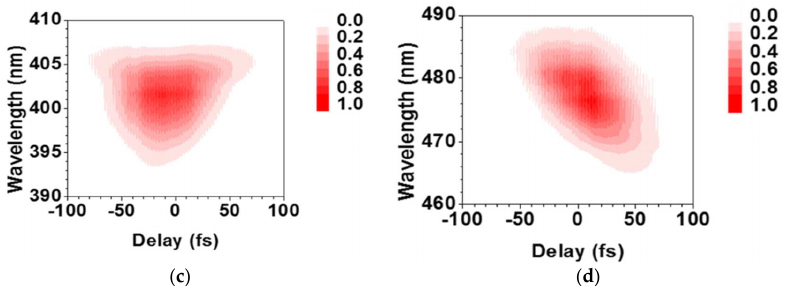
Figure 6. ( a ) Measured XFROG trace; ( b ) Retrieved XFROG trace from ( a ); ( c , d ) The expanded views of